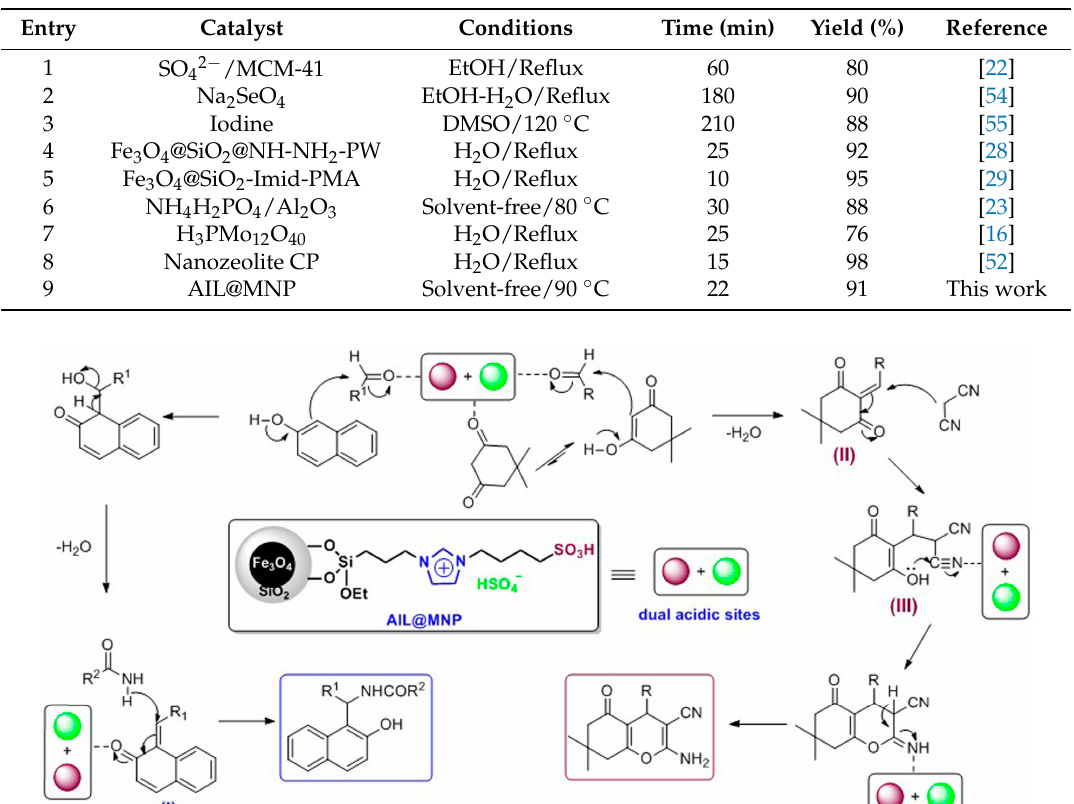
Figure 1. Recycling experiment of AIL@MNP. The structure and morphology of the recovered catalyst after six runs were especially investigated. According to the FT ‐ IR characteristic peaks in comparison with the fresh one, it had no obvious change in structure (Figure 2). And there was also no apparent change in the morphology and size by a TEM observation of the recovered catalyst (Figure 3). Moreover, the IL content of the recovered catalyst was determined by elemental analysis again and it was found that 0.53 mmol/g of IL was still grafted on the surface of magnetic nanoparticle, nearly the same as before. These results